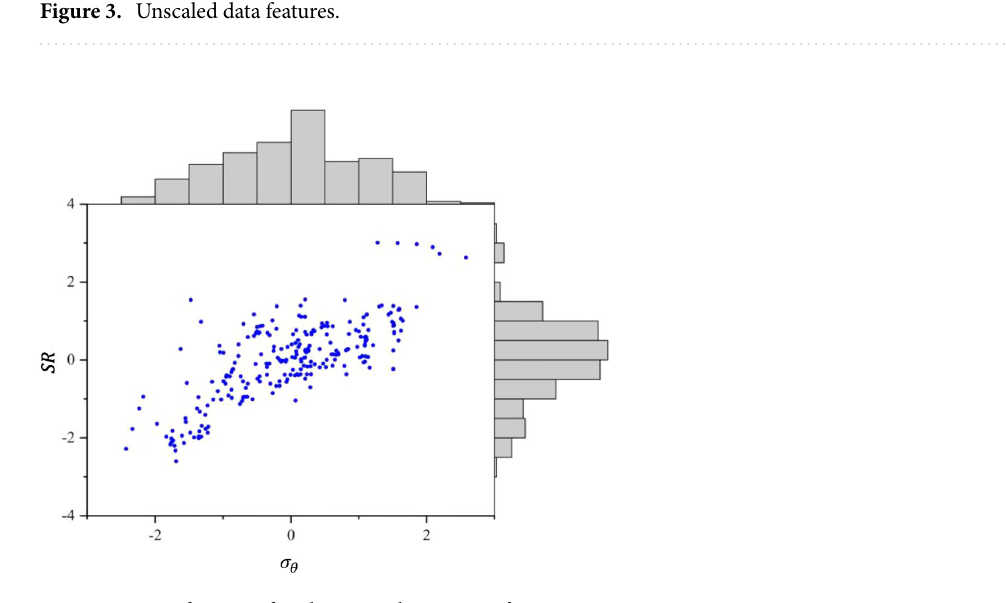
Figure 4. Data features after the Yeo–Johnson